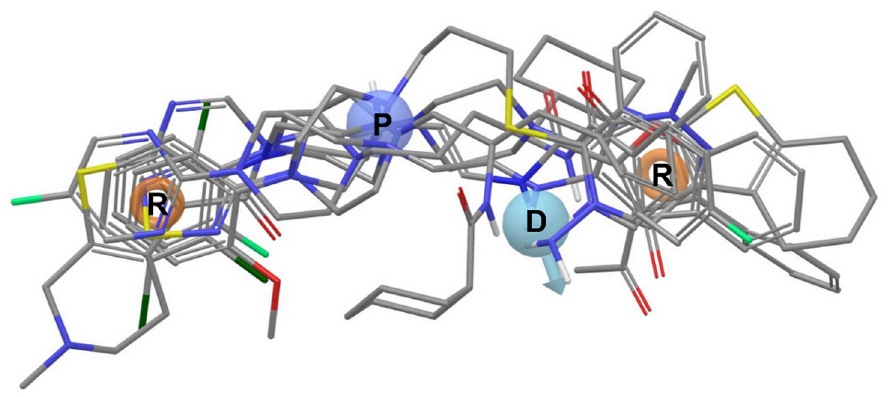
Figure 7. Exemplary pharmacophore hypothesis selected for arylpiperazines with classical amide fragment. Exemplary pharmacophore hypothesis selected for arylpiperazines with classical amide fragment mapping 6 out of 10 cluster representatives. The model fit 462 of the 533 compounds (87%) in the cluster. The feature abbreviations are: hydrogen-bond donor – D , positively charged group – P , aromatic ring – R . doi: